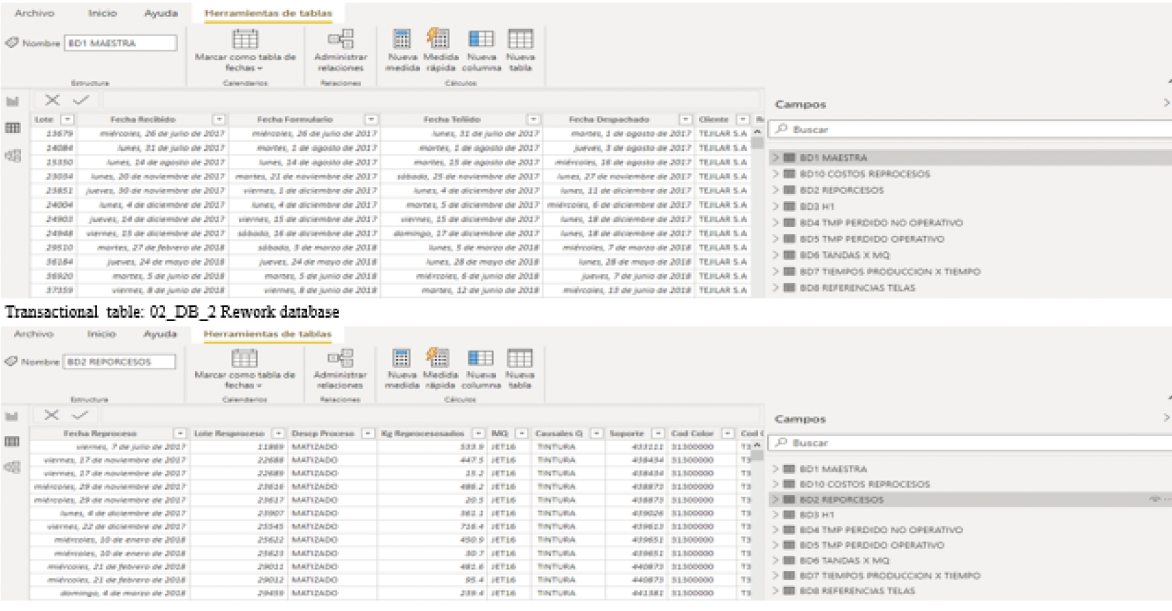
Figure 6. Matrix databases example in Power